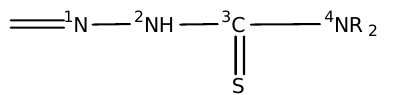
Figure 1: Thiosemicarbazone uncomplexed ligand moiety.